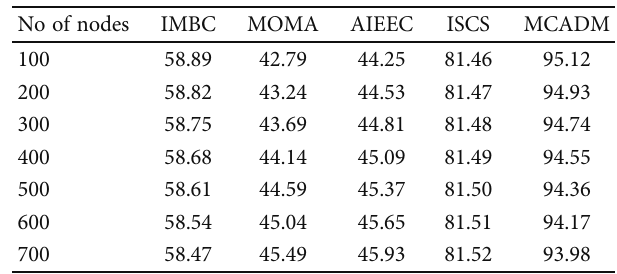
Table 1: Management of fully functional device nodes.